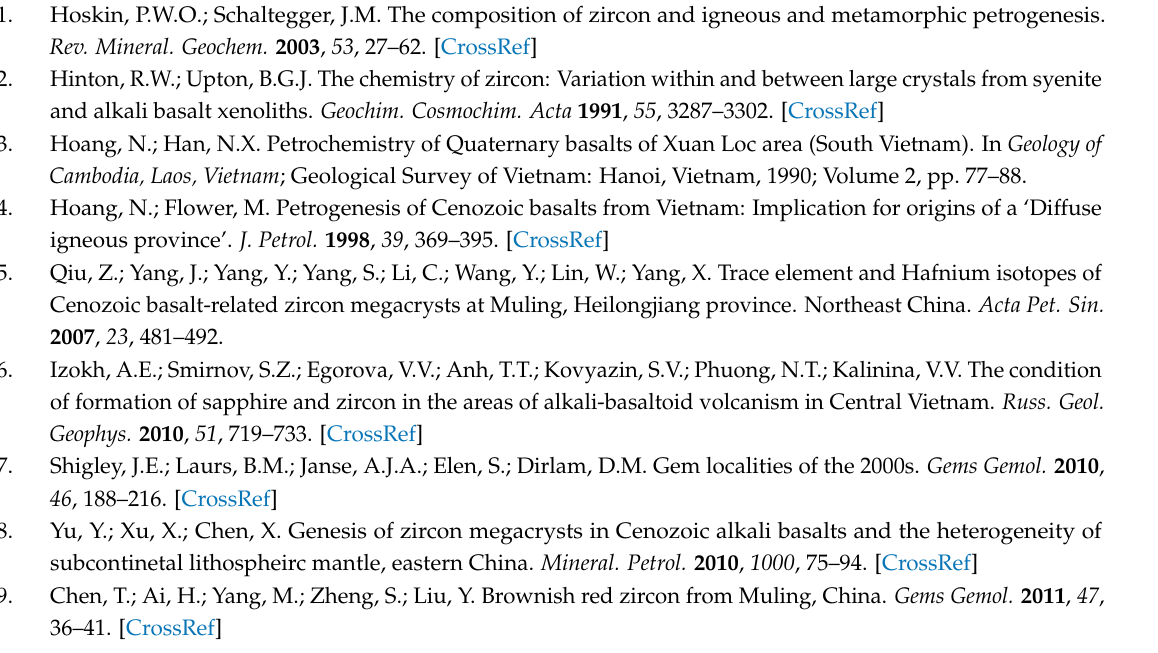
Table S1: Results of LA-ICP-MS trace-element analyses of multiple measurement spots on zircon samples from Central Highlands, Vietnam (DL1, DL2, DL3, C05, C07, and C16) and from Ratanakiri, Cambodia (Rata), Table S2: U-Pb isotopic ratios and ages obtained from LA-ICP-MS analyses of zircon samples from Central Highlands, Vietnam, Table S3: U-Th-Pb isotopic ratios and ages obtained from LA-ICP-MS analyses of zircon samples from Dak Lak, Central Highlands,